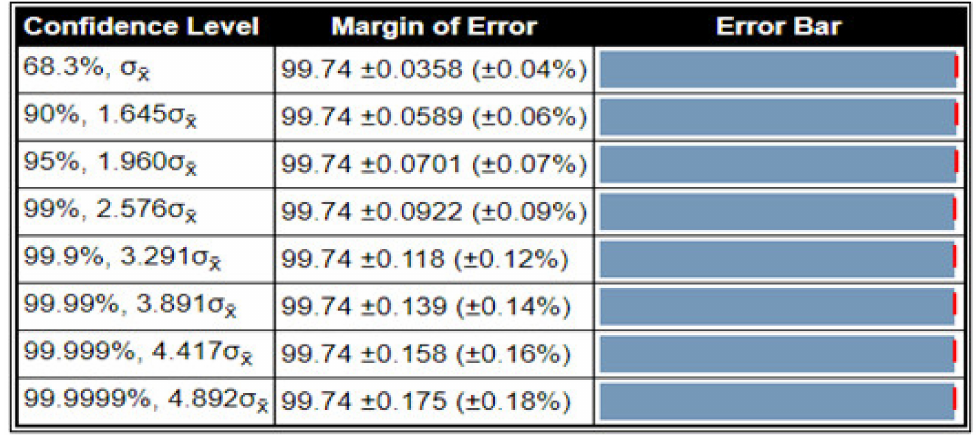
Figure 10. Statistical confidence interval of proposed stomach classification